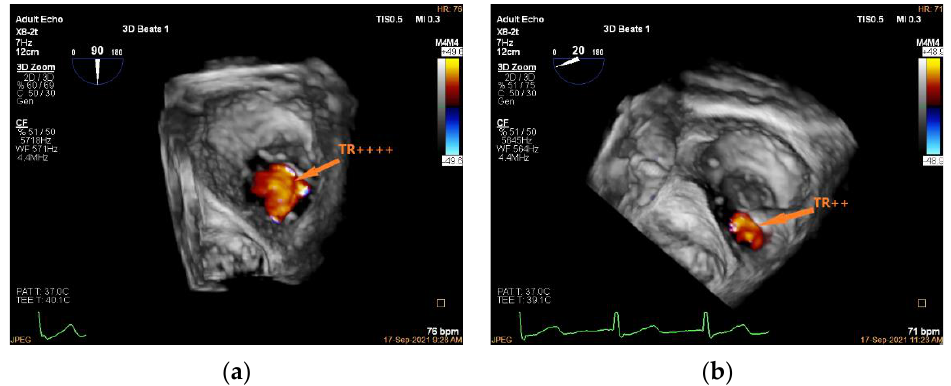
Figure 9. Three-dimensional CDI demonstrating TR jet before and after K-Clip ™ implantation. ( a ): Three-dimensional CDI showing severe TR; ( b ): 3D CDI showing residual mild-moderate TR after transcatheter tricuspid annuloplasty. TR, tricuspid regurgitation.